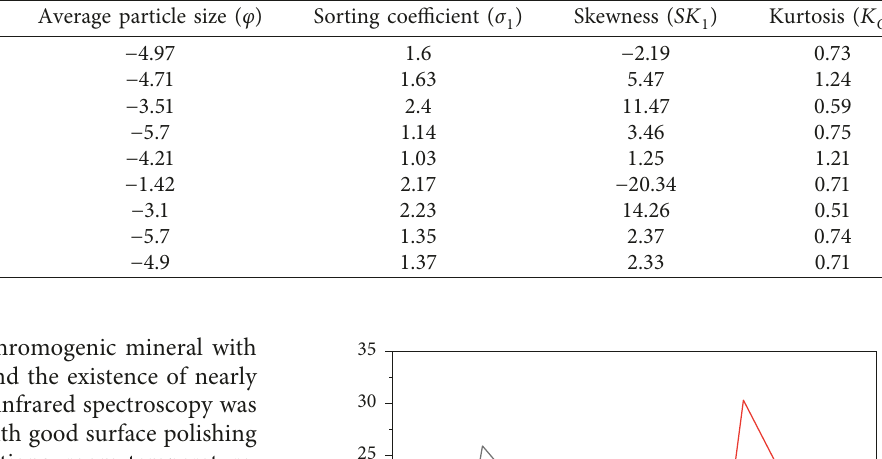
Table 3: Gravel composition and particle size parameters.